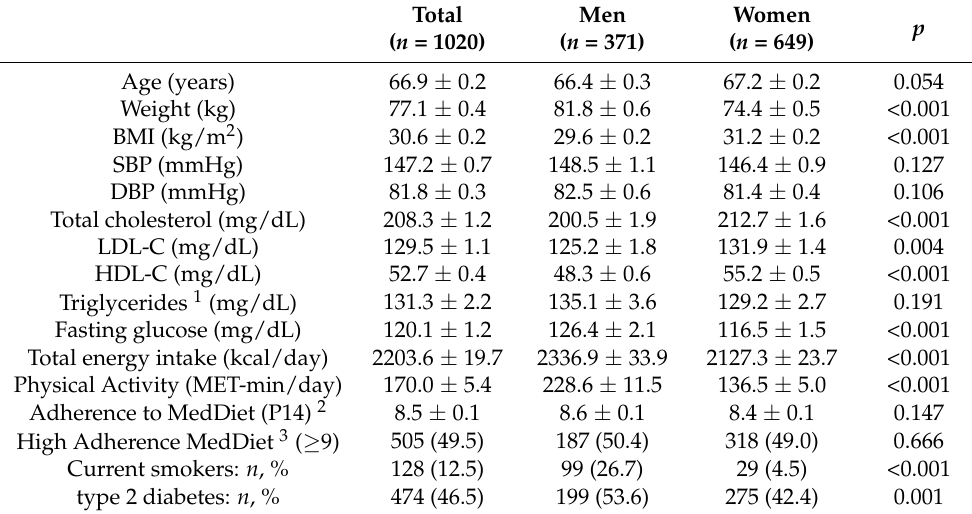
Table 1. Demographic, clinical, and biochemical characteristics of the study population according to